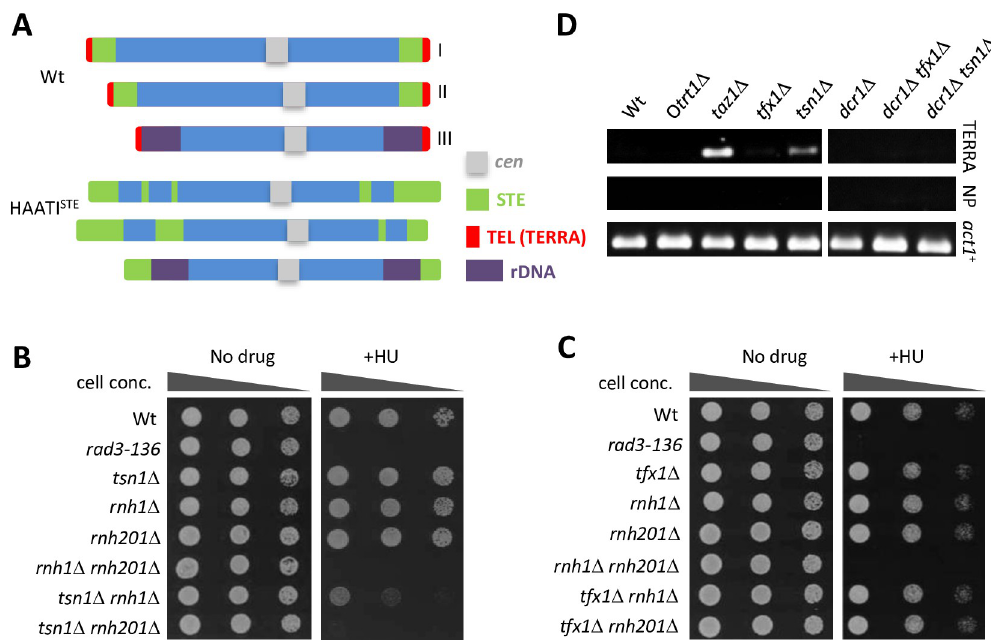
Fig 3. tsn1 + , but not tfx1 + , is required for replicative stress response in Dcr1-deficiency in the absence of telomeres. (A) Schematic of the S . pombe chromosome structure for wild-type (Wt) and HAATI STE strain. The three Wt chromosomes are shown on the top (I, II and III represent the Wt chromosome designations); the three HAATI STE chromosomes are shown on the bottom [61]. cen = centromere; STE = subtelomeric elements; TEL = telomere, template for TERRAs; rDNA = ribosomal DNA. (B) 10-fold serial dilutions of indicated strains were spotted onto YEA with or without HU (10 mM). (C) 10-fold serial dilutions of indicated strains were spotted onto YEA with or without HU (10 mM). (D) Agarose gel images showing reverse transcriptase PCR products for RNA extracted from the indicated strains. Left hand set is as previously reported [35]; right hand set from this study. taz1 Δ –control for elevated TERRA; O trt1 Δ –no telomere control. NP–No primer control. Primers to act1 + used as cDNA positive